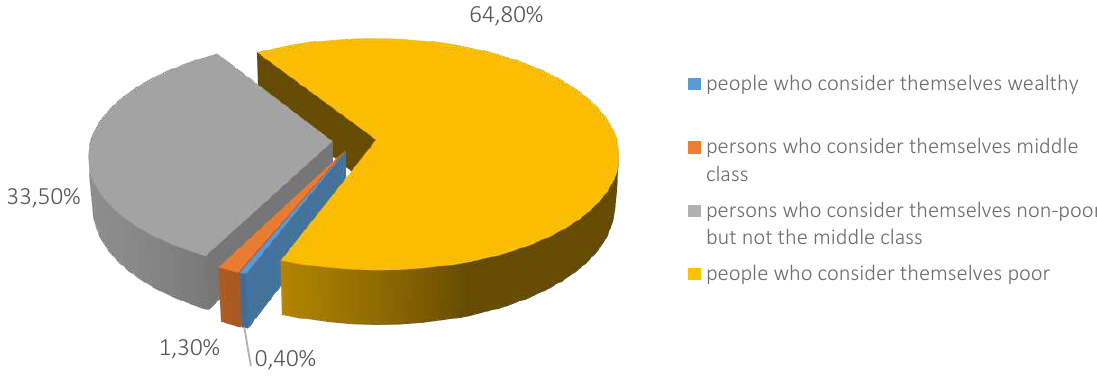
Figure 1. Distribution of households by self-assessment of material well-being, %